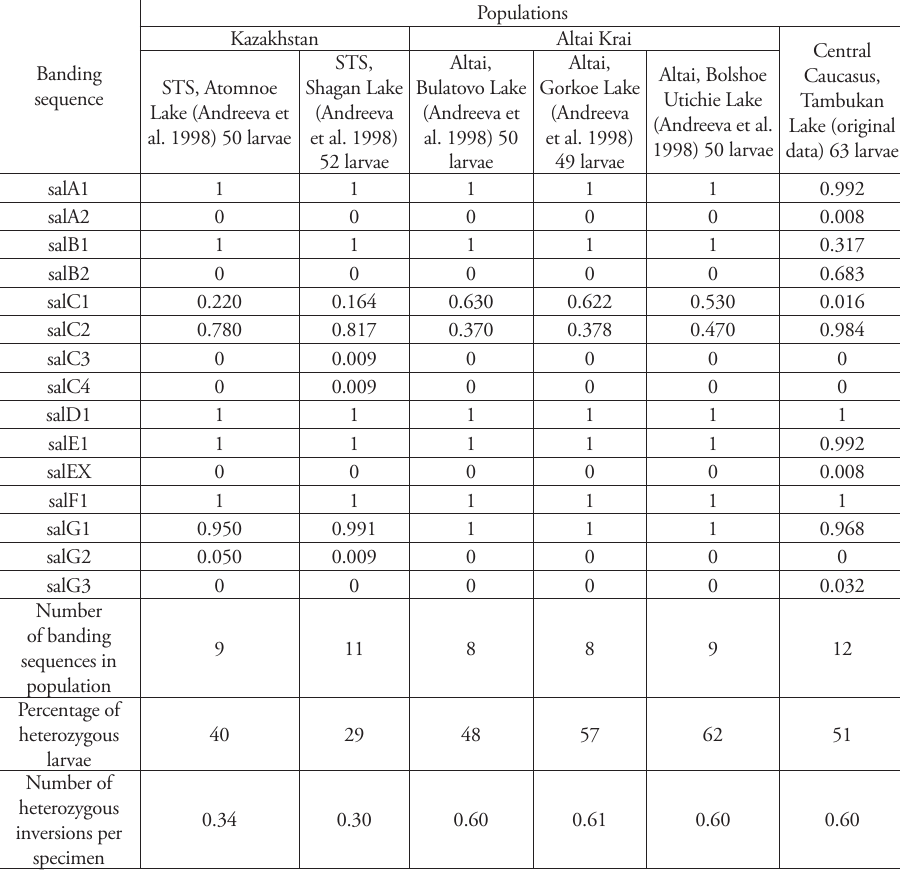
Table 2. Frequency of banding sequences in different populations of G. salinus .